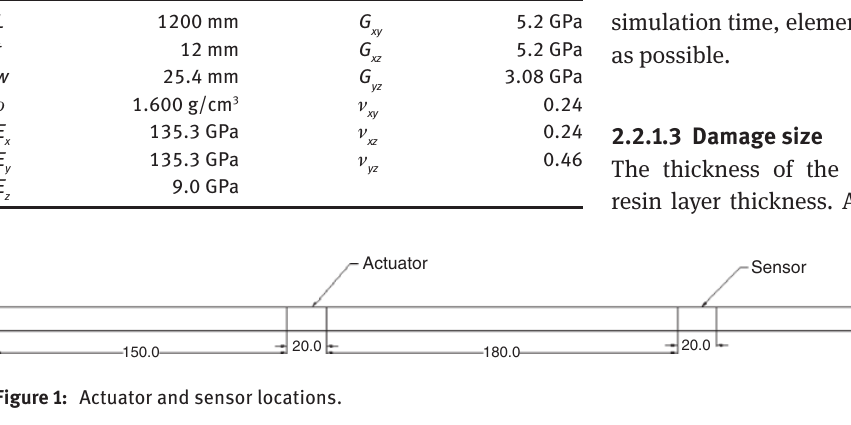
Figure 1: Actuator and sensor